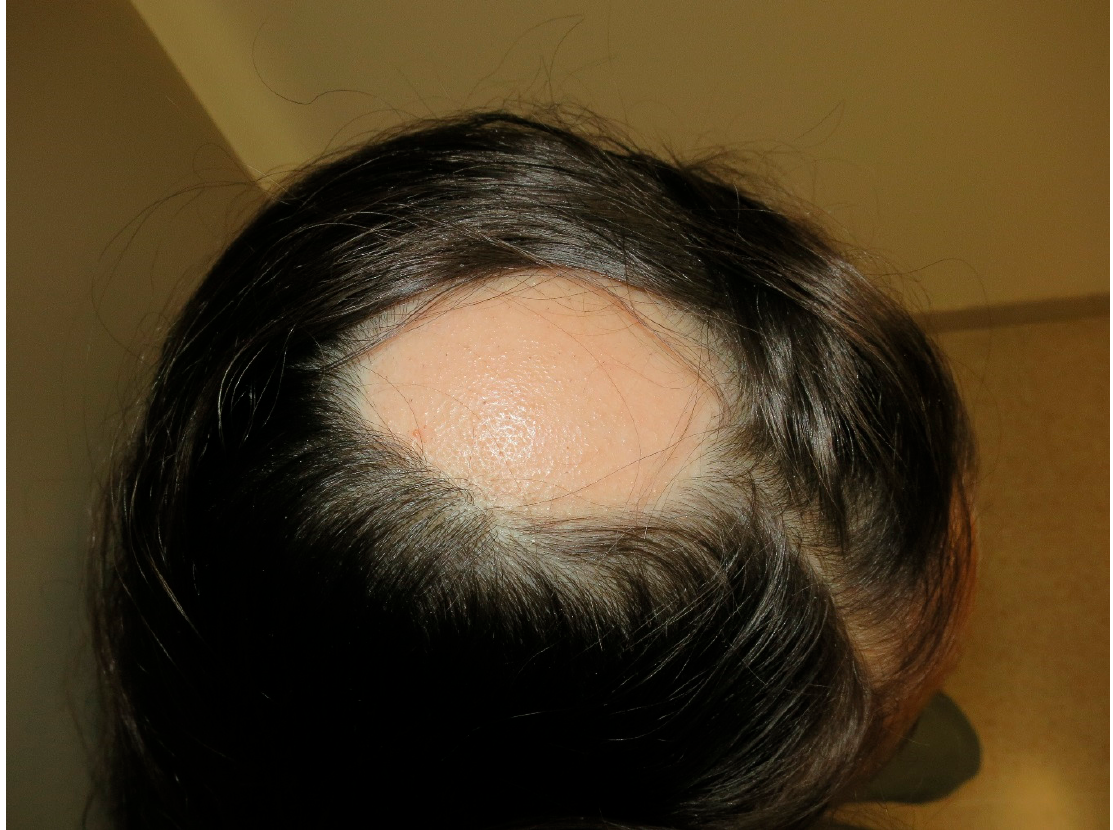
Figure 7. Alopecia areata. Patchy head hair loss.